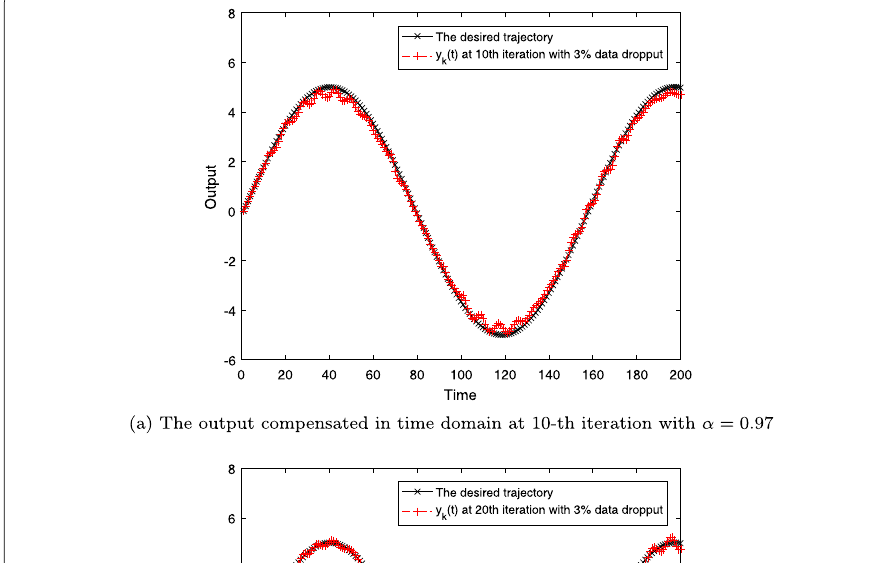
mined by input error at the actuator side; consequently, only the method to compensate the dropped input data in iteration domain guarantees that the output error of networked ILC systems converges to